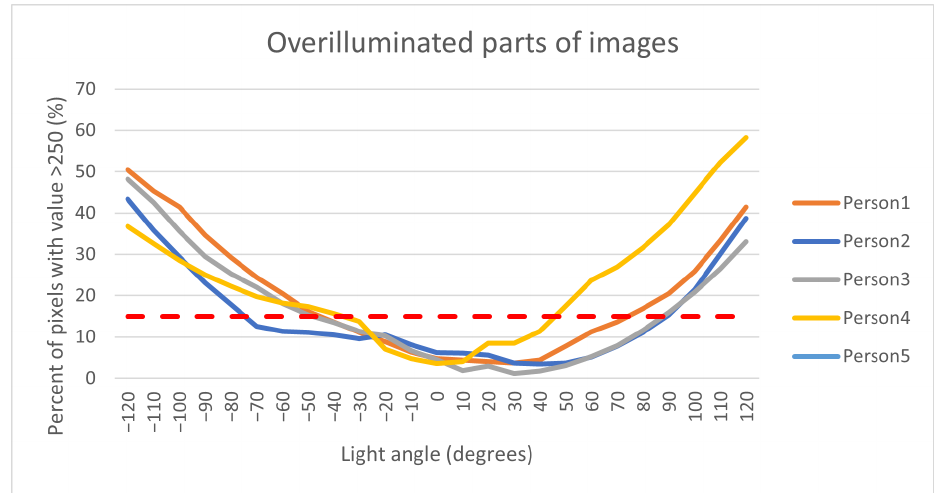
Figure 9. Display in the